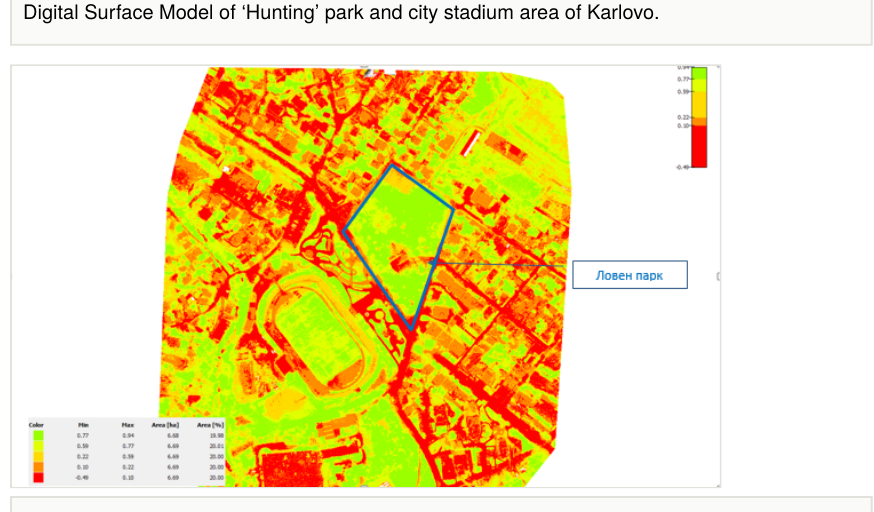
Figure 10. NDVI model of ‘Hunting’ park and city stadium area of Karlovo (Min- minimal NDVI score for the class, max-maximal NDVI score for the class, area (ha) total area of the NDVI class, area (%)- relative share of the NDVI class within the studied